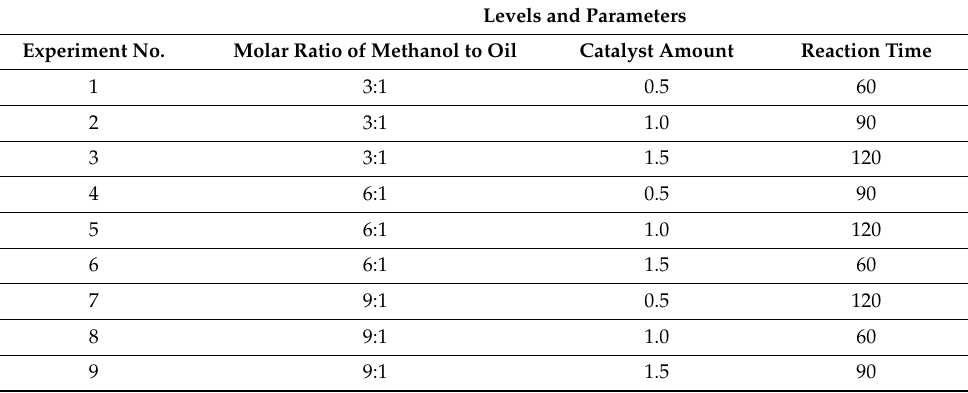
Levels and Parameters